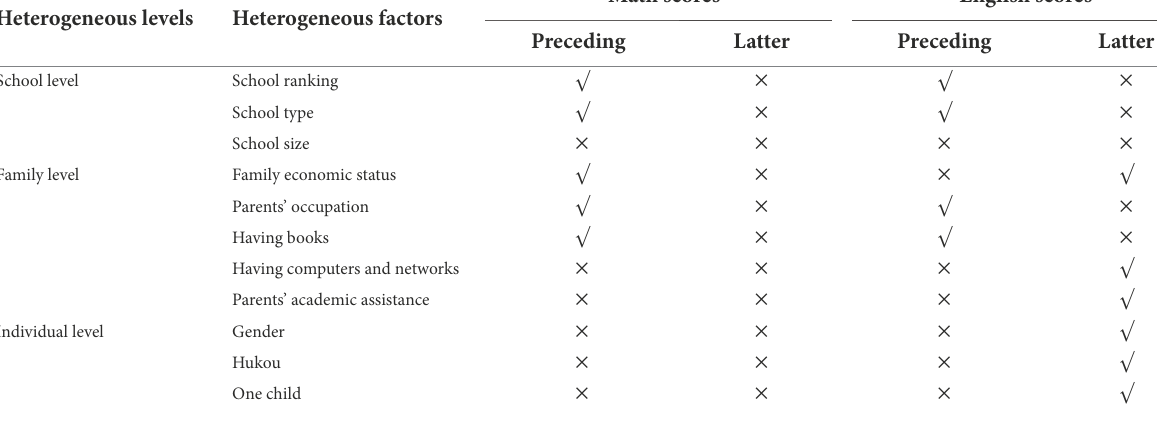
TABLE 7 Path test of the moderation effect of national education finance.